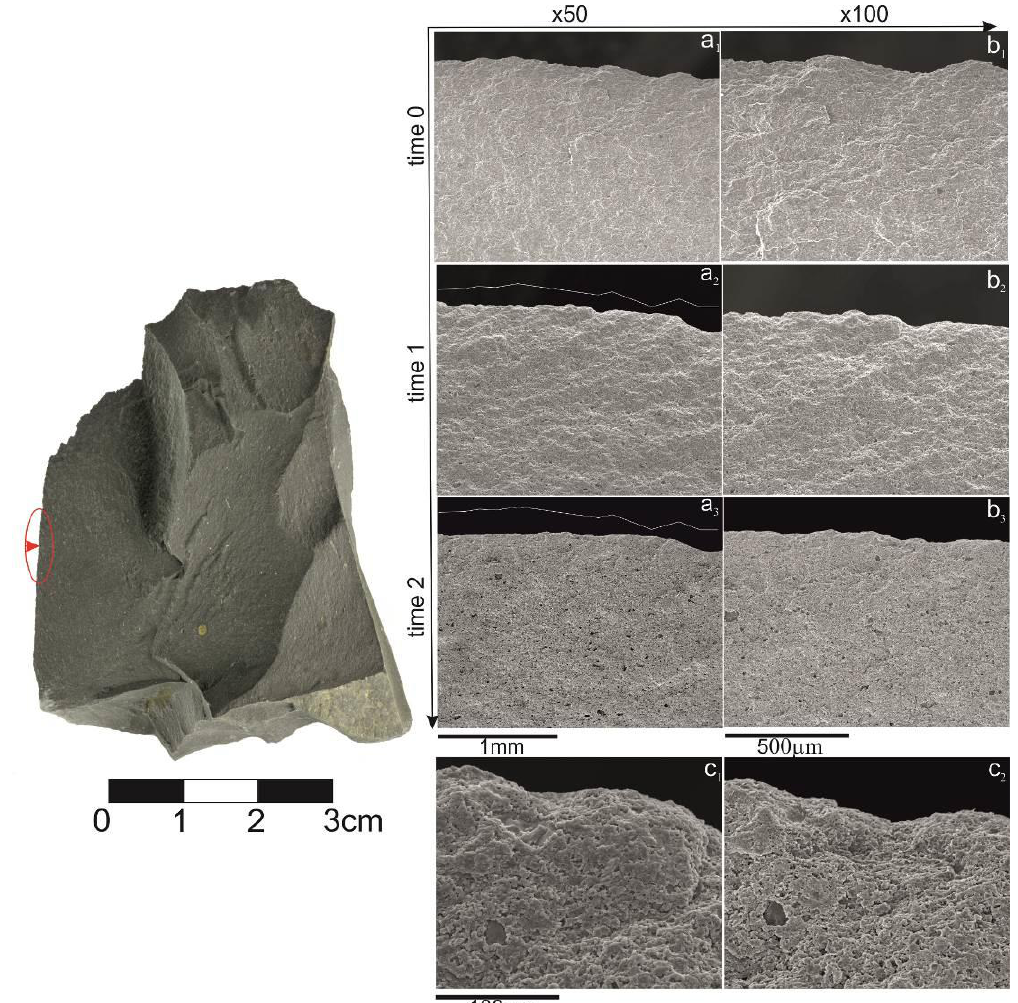
Figure 9. Example of edge damage seen on Ishbas1 used for the PDSM experiments. The control point is taken on the dorsal left lateral in the area indicated by circle and arrow, using the SEM at x50 – x100 magnifications; a – a show the same portion of the edge at its original stage (a 1 3 hours of tumbling (a3) experiments seen at x50 magnification. The lines along the edge in a changes of the edge in comparison with original stage of the edge (a at x100 magnification; c & c show a detail of edge damage and some rounding and abrasion after trampling (c 1 2 and tumbling (c ) at x500 2